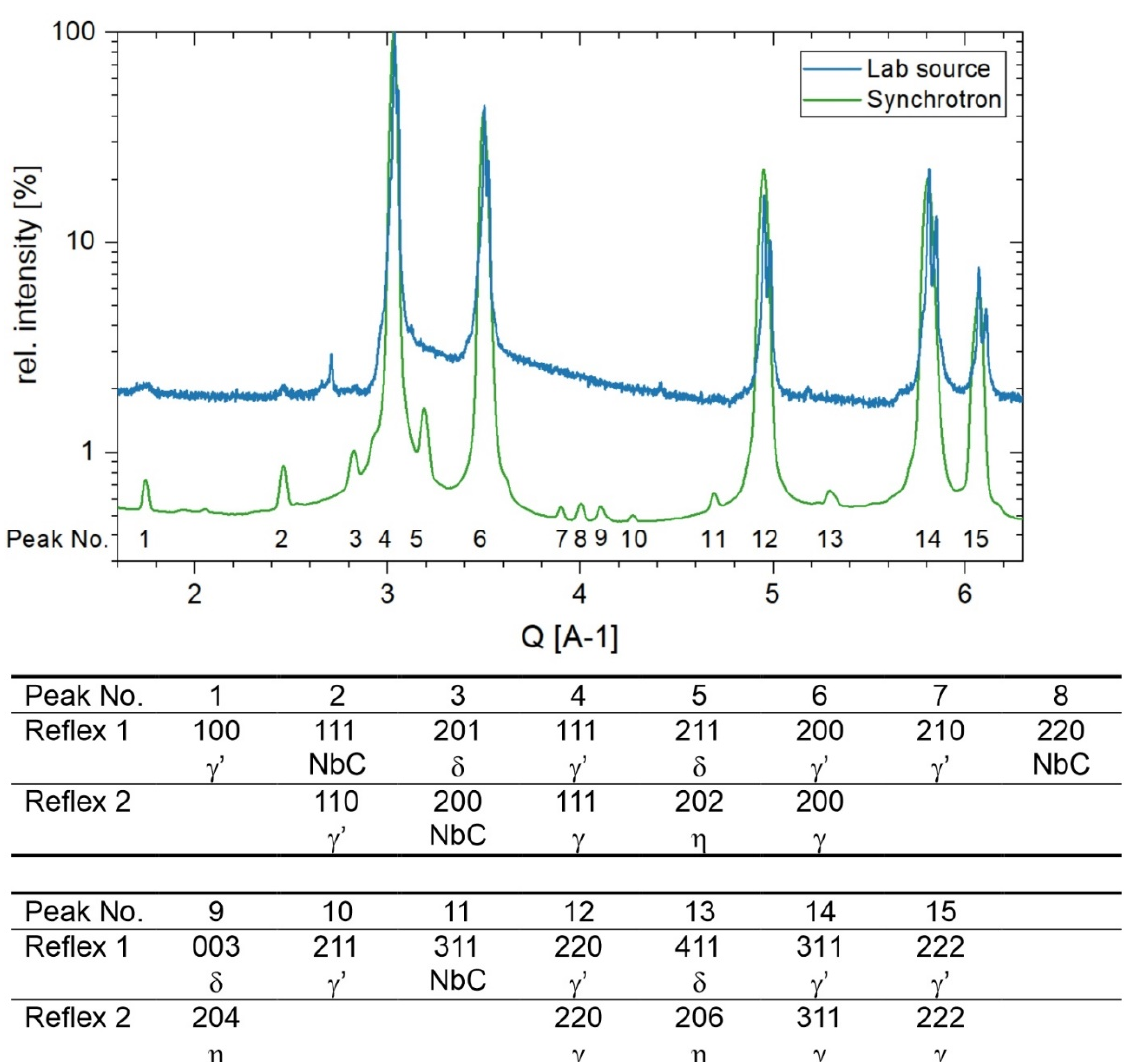
Figure 2. Room temperature diffraction pattern measured with lab-source and synchrotron X-rays. On the bottom, a list of selected indexed diffraction peaks for the different phases is shown.